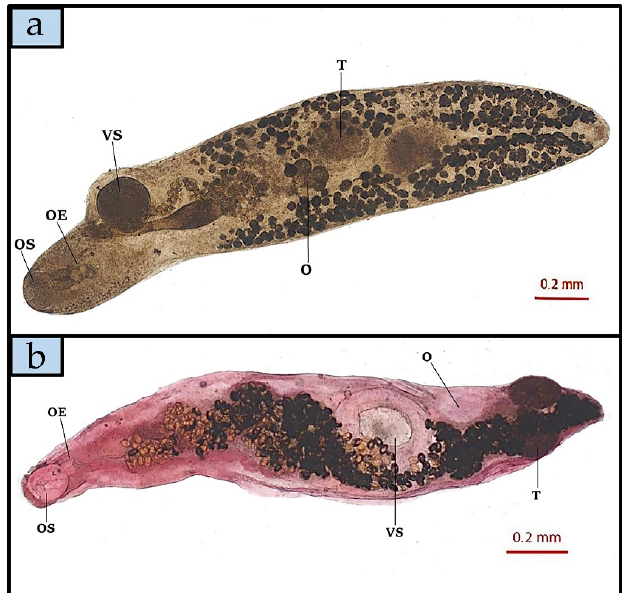
Figure 4. Podocotyle temensis specimen ( a ), glycerine diaphanization (O, Trilobal ovarian tissue; T, Testis; OE, Oesophagus; OS, Oral sucker; VS, Ventral Sucker) and Hemipera sp. specimen ( b ), after Semichon’s carmine red technique staining (O, Ovary; T, Testis; OE, Oesophagus; OS, Oral sucker; VS, Ventral Sucker), both isolated from Epinephelus marginatus intestine. The results of Pearson correlation were confirmed by the linear regression model (Figure